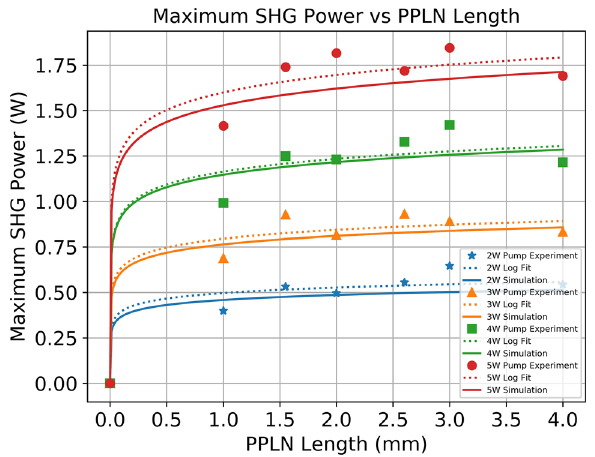
Figure 2. Measured maximum SHG power vs. PPLN length for several values of 808 nm pump power.